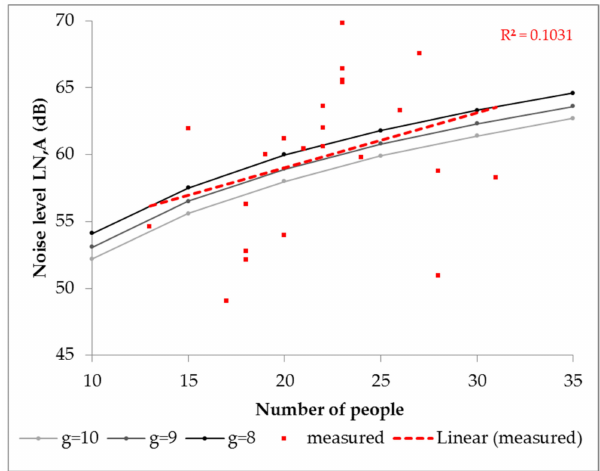
Figure 3. Prediction curves of the assumed group size parameter g [24]: measured (with linear regression) and predicted ambient noise levels as a function of